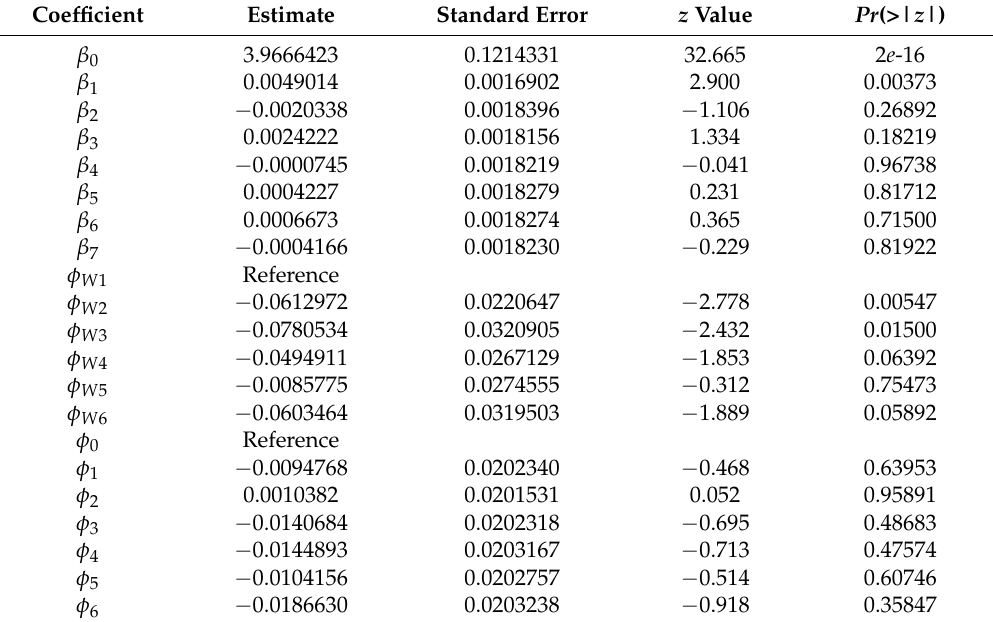
Table 2. Parametric coefficients of the covariates in Equation